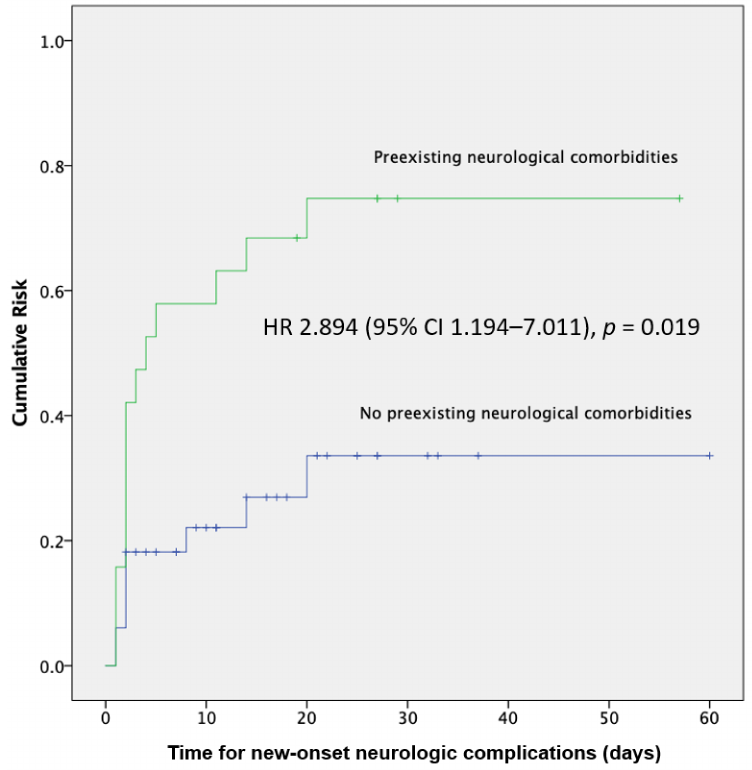
Figure 1. Kaplan–Meier estimates of the cumulative risk of new-onset neurological